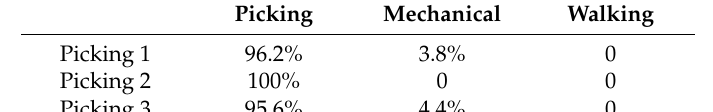
Table 4. The identification rate of picking signals.